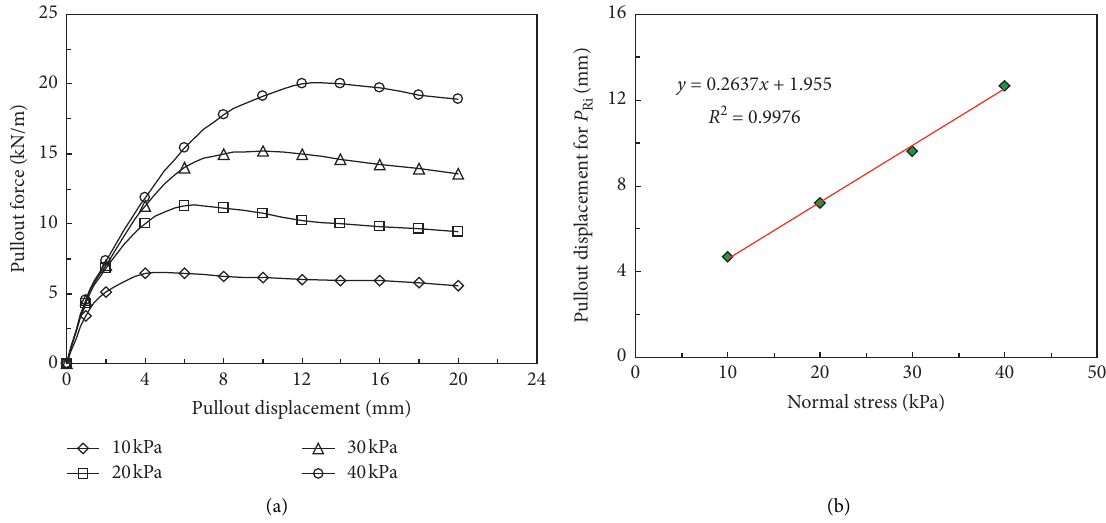
Figure 6: Pullout force versus pullout